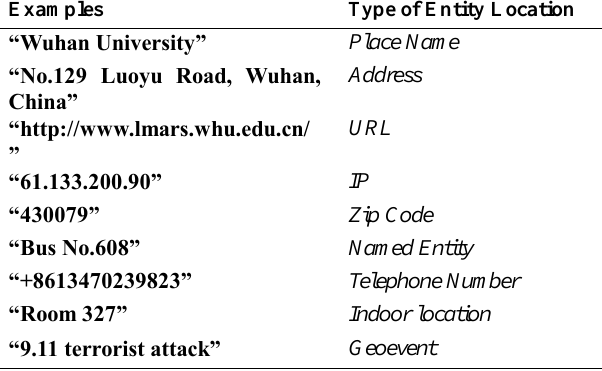
Figure 2. Composition of Pan-Information Location